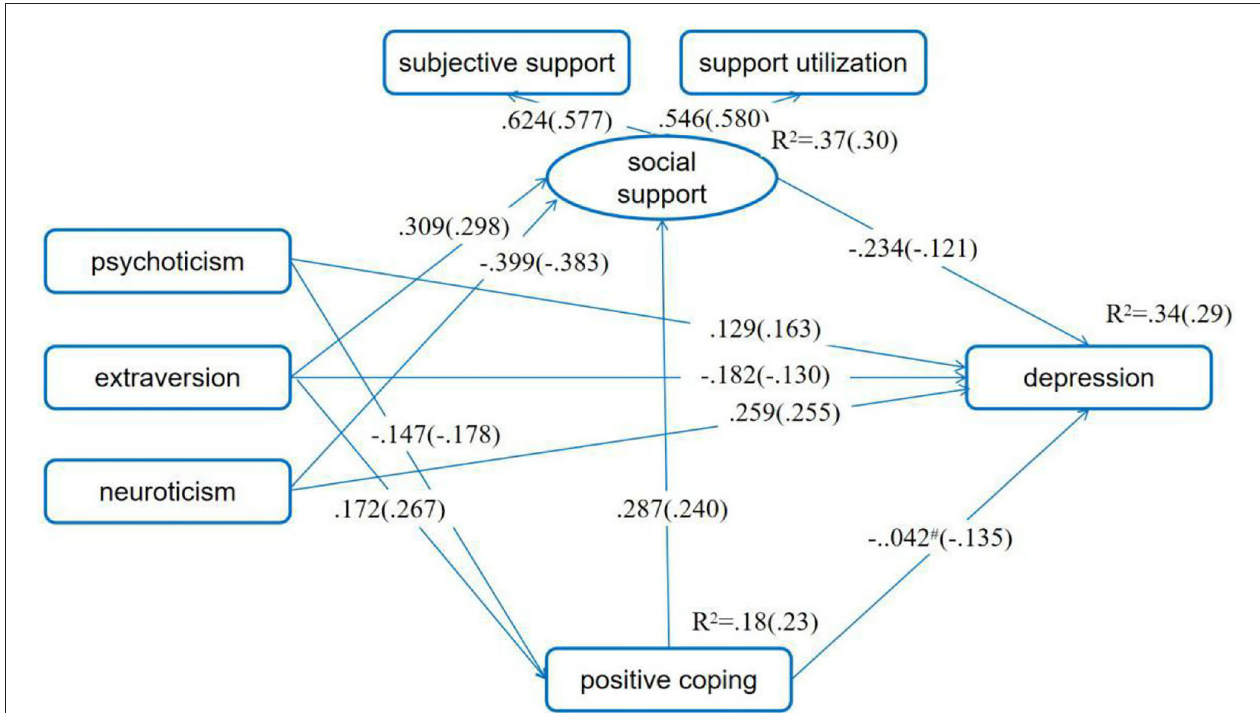
FIGURE 3 | SES as moderator in the chain mediating model of positive coping and social support in the association between personality and depressive symptoms. Standardized path coefficients before parentheses were for the low SES group, and those in the parentheses were for the high SES group. # p > 0.05, while the p -values for other standardized path coefficient were all < 0.05. The first pregnancy or not, having adverse pregnancy experience or not, being pregnant as planned or not, and number of weeks of pregnancy were set as control